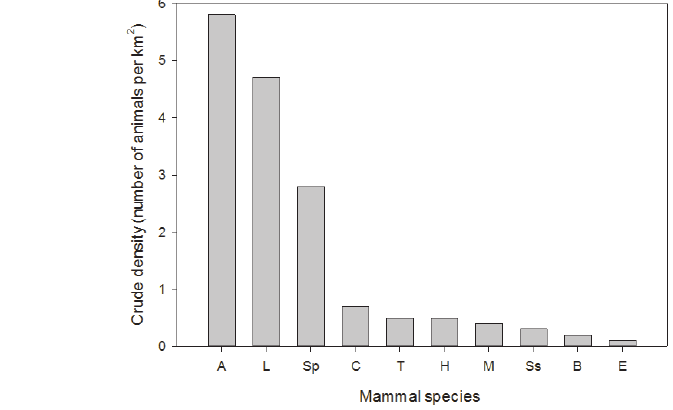
Figure 8: Crude densities of major herbivores in Wilpattu National Park were ranked in the order of numerical abundance; mammal species as in Figure 5. (After Eisenberg and Lockhart,